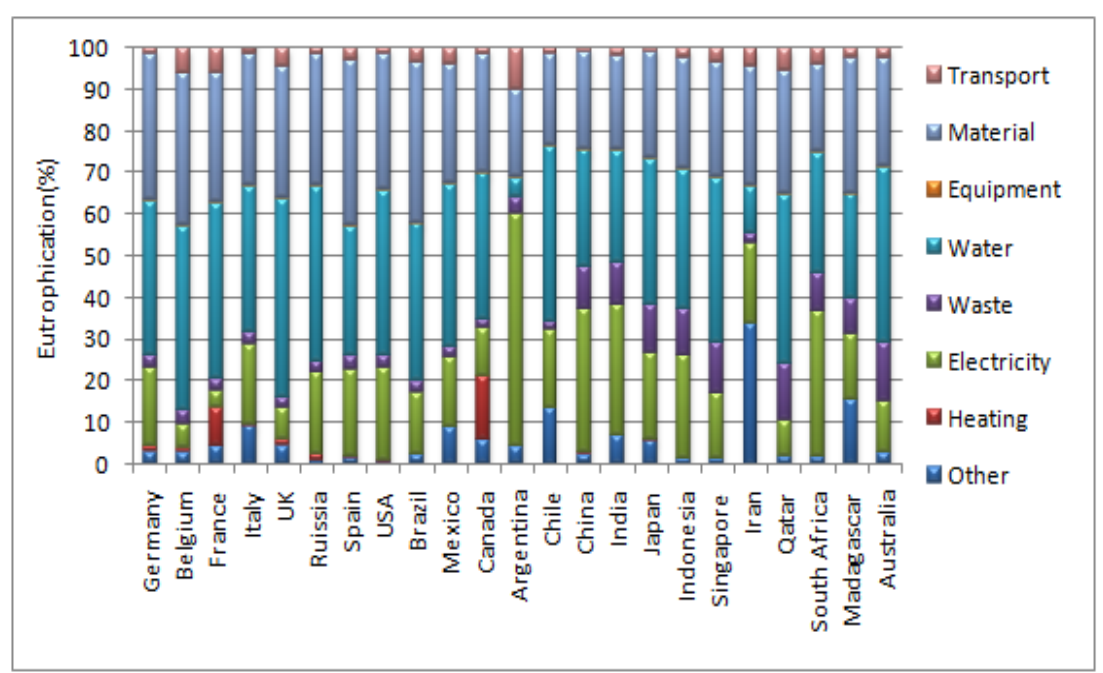
Figure 7. Frequency (%) of the different environmental components in the generation of the acidifi- cation for some countries located in the five continents of the world.